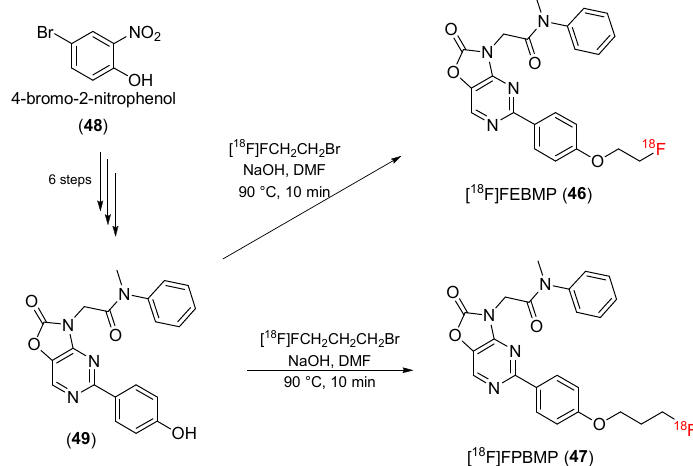
Scheme 14. Synthesis of [ 18 F]FEBMP and [ 18